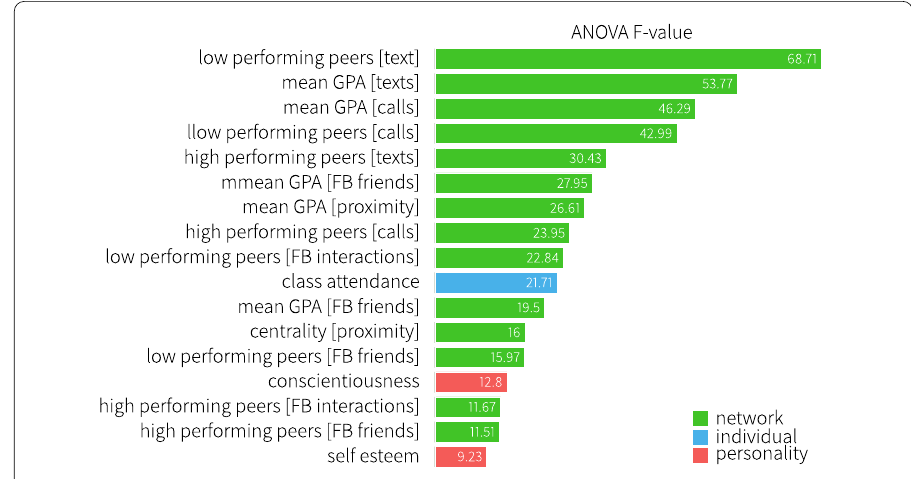
Figure 2 Feature importance ranking. Results from ANOVA F-test for 3-class classification. Features which did not achieve sufficient significance ( p ≥ 0.001) are omitted